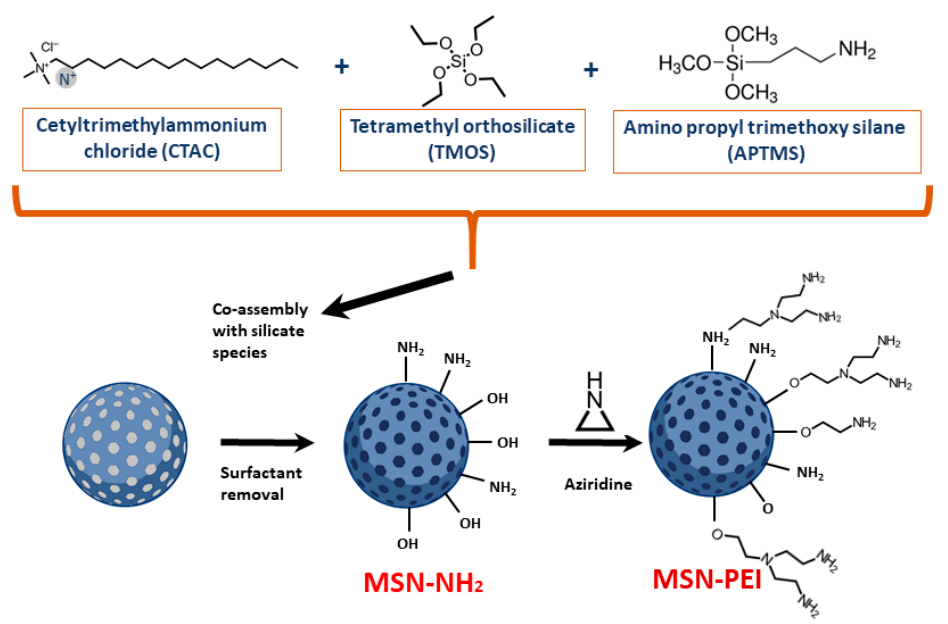
Figure 1. A graphic schematic presentation of a PEI-MSN.